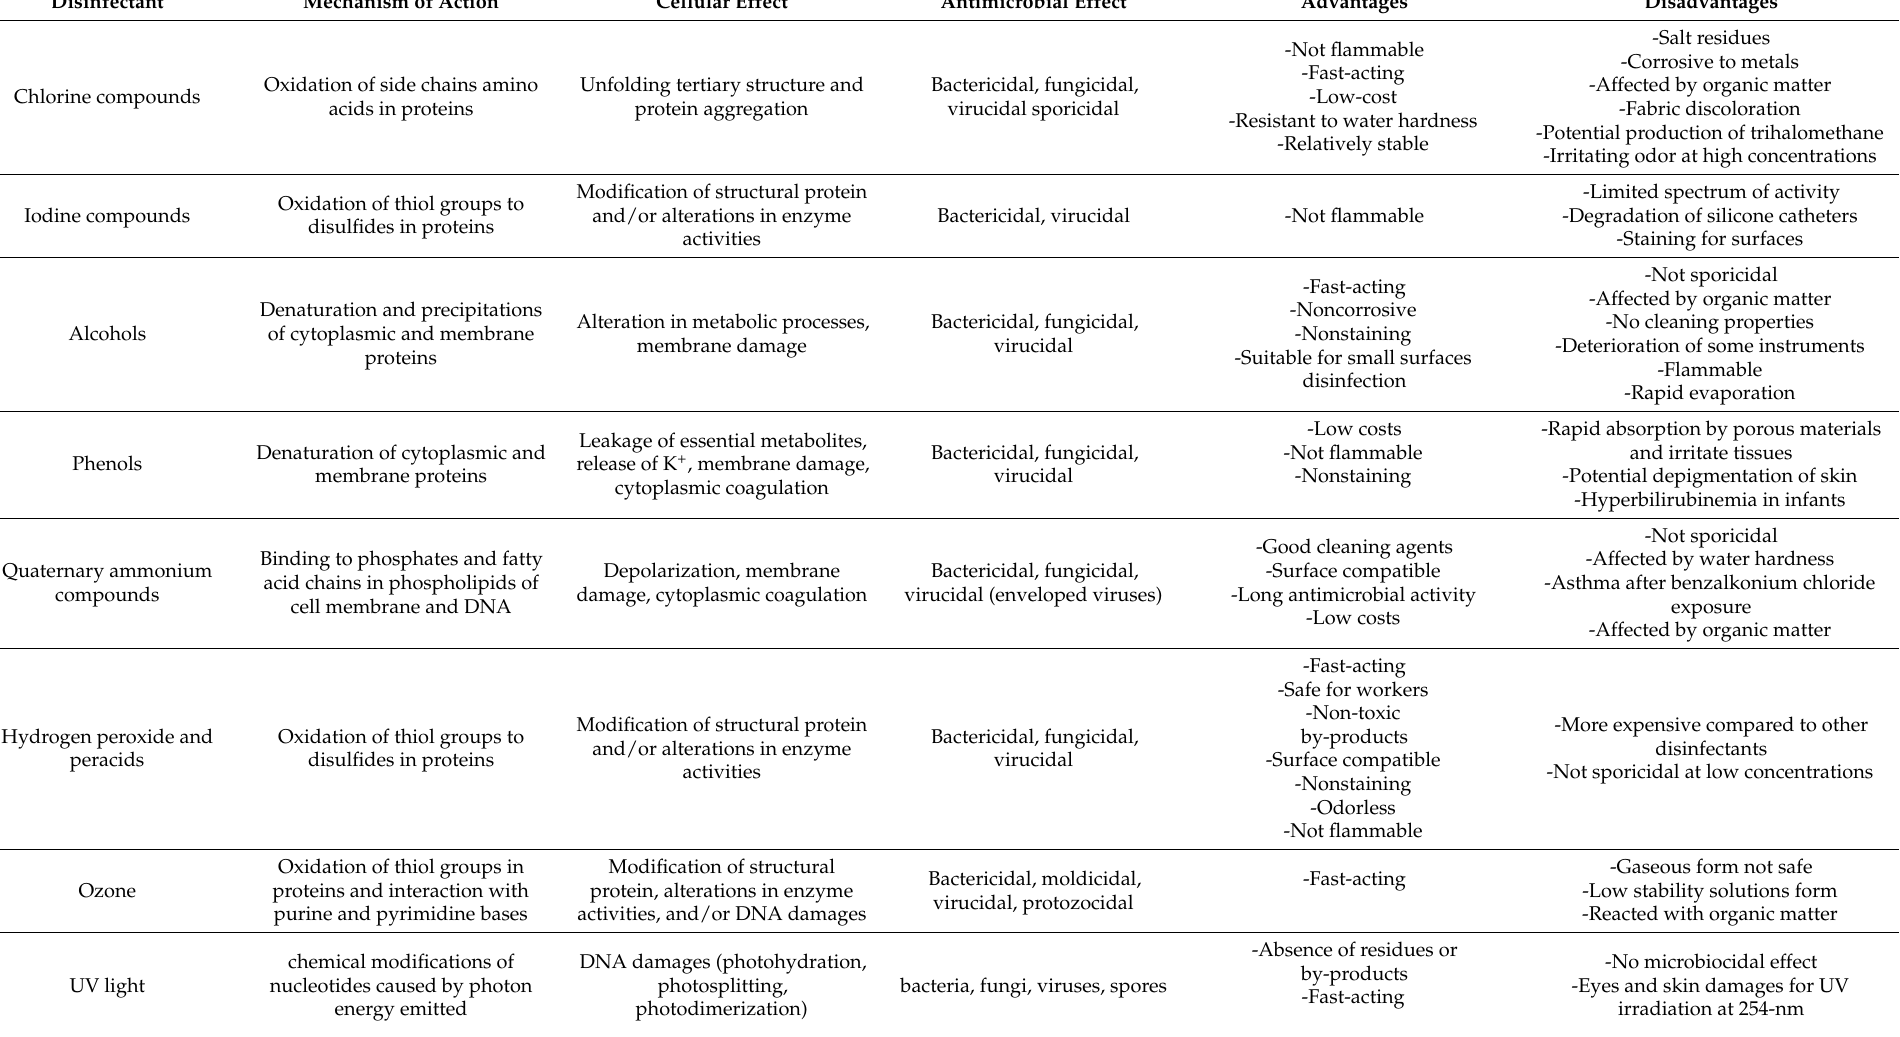
Table 5. Summary of advantages and disadvantages of common surface